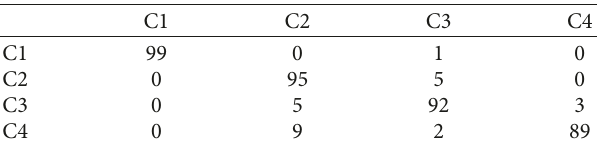
Figure 12: SDP images of rolling bearing under different conditions. (a) Roller bearing with inner-race fault. (b) Roller bearing with out- race fault. (c) Roller bearing with ball fault. (d) Normal roller bearing. Table 5: Classification